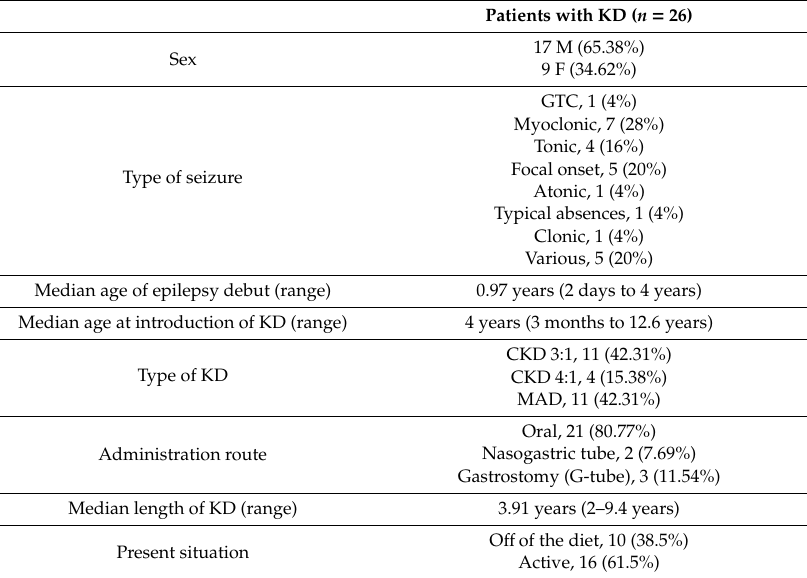
Table 1. Characteristics of the patients in the